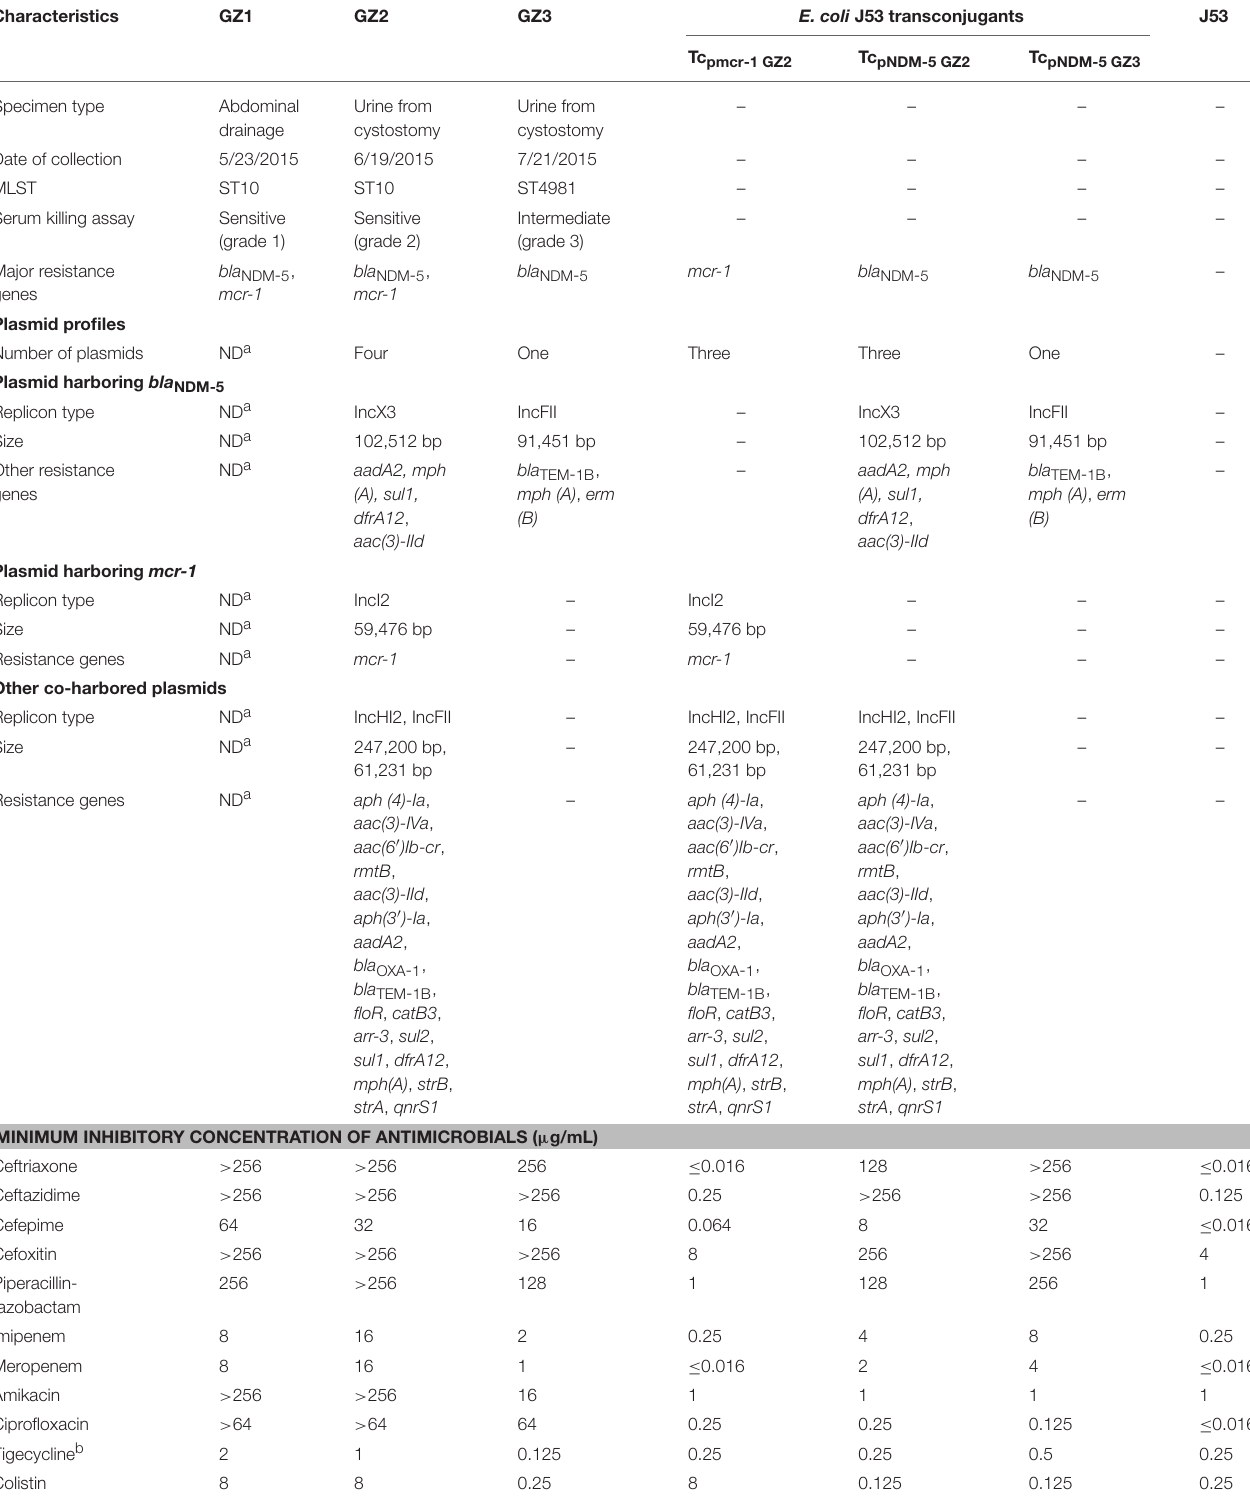
TABLE 1 | Characteristics of the isolated E. coli strains and its